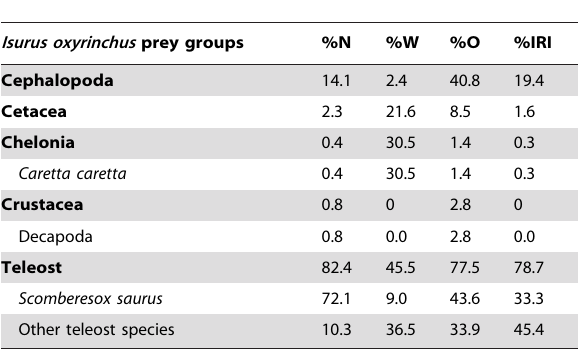
Isurusoxyrinchus prey